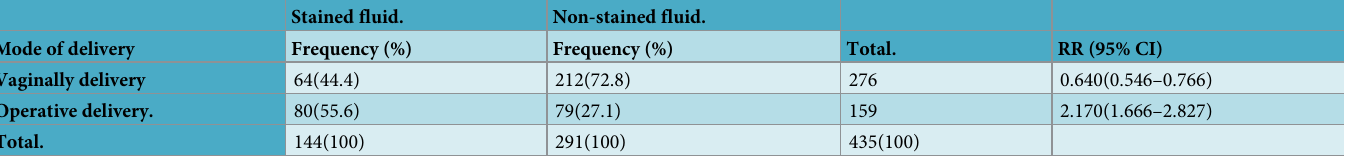
Table 3. Mode of delivery of laboring mothers at SPHMMC from July 1 to December 30, 2018. Stained